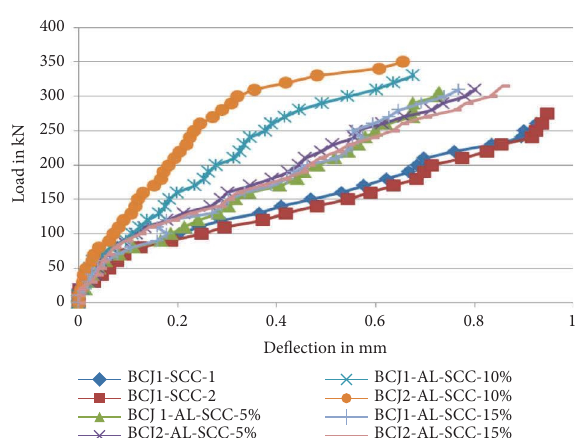
Figure 9: Load vs. defection behaviour of all tested SCC-BCJ